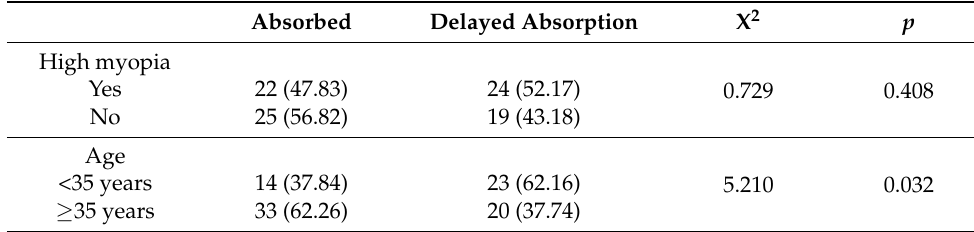
Table 3. Binary logistics regression analysis of high myopia and age for SRF absorption. Table 2. Fisher’s exact test results of high myopia and age for SRF absorption. β Absorbed Delayed Absorption X 2